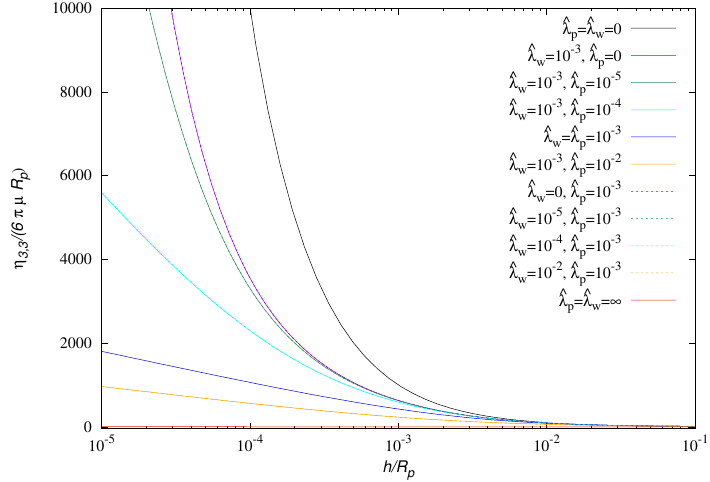
Figure 4. Dimensionless hydrodynamics resistance coefficient η 3,3 / ( 6 π µ R p ) vs h / R p obtained by keeping fixed the slip length ˆ λ i = λ i / R p = 10 − 3 on the i -th surface ( i = w , p ) and varying the slip length on the other obtained by solving the Goren’s equations. Observe that the curves corresponding to i = w and i = p practically overlap in this range of parameter